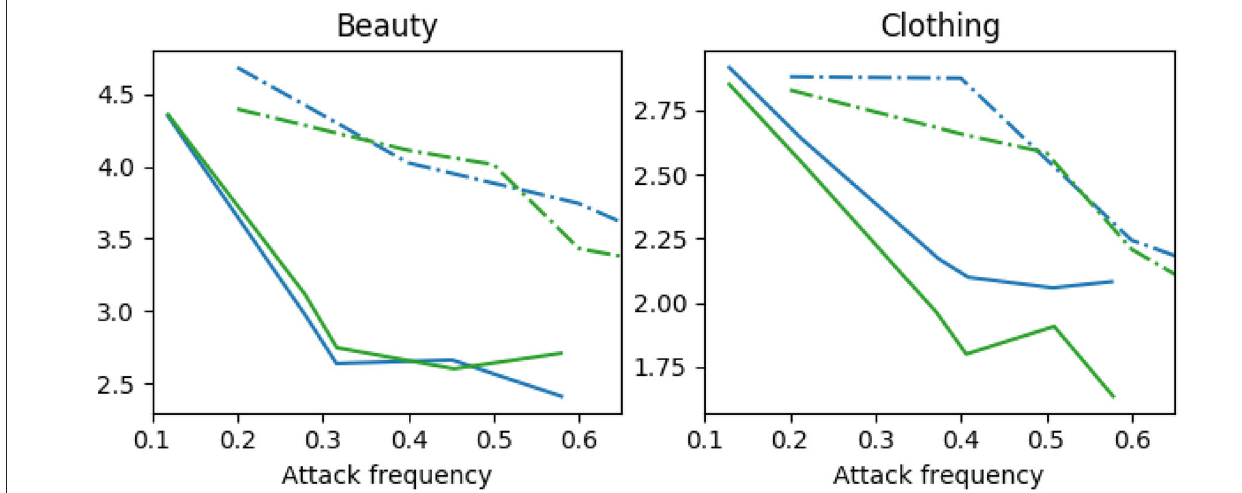
FIGURE 3 | Normalized Discounted Cumulative Gain of attack frequency on Amazon Beauty and Clothing. Dashdot lines represent random attacks, solid lines are strategically-timed attacks. Blue lines are FGSM l inf attacks, green lines are FGSM l 1 attacks.